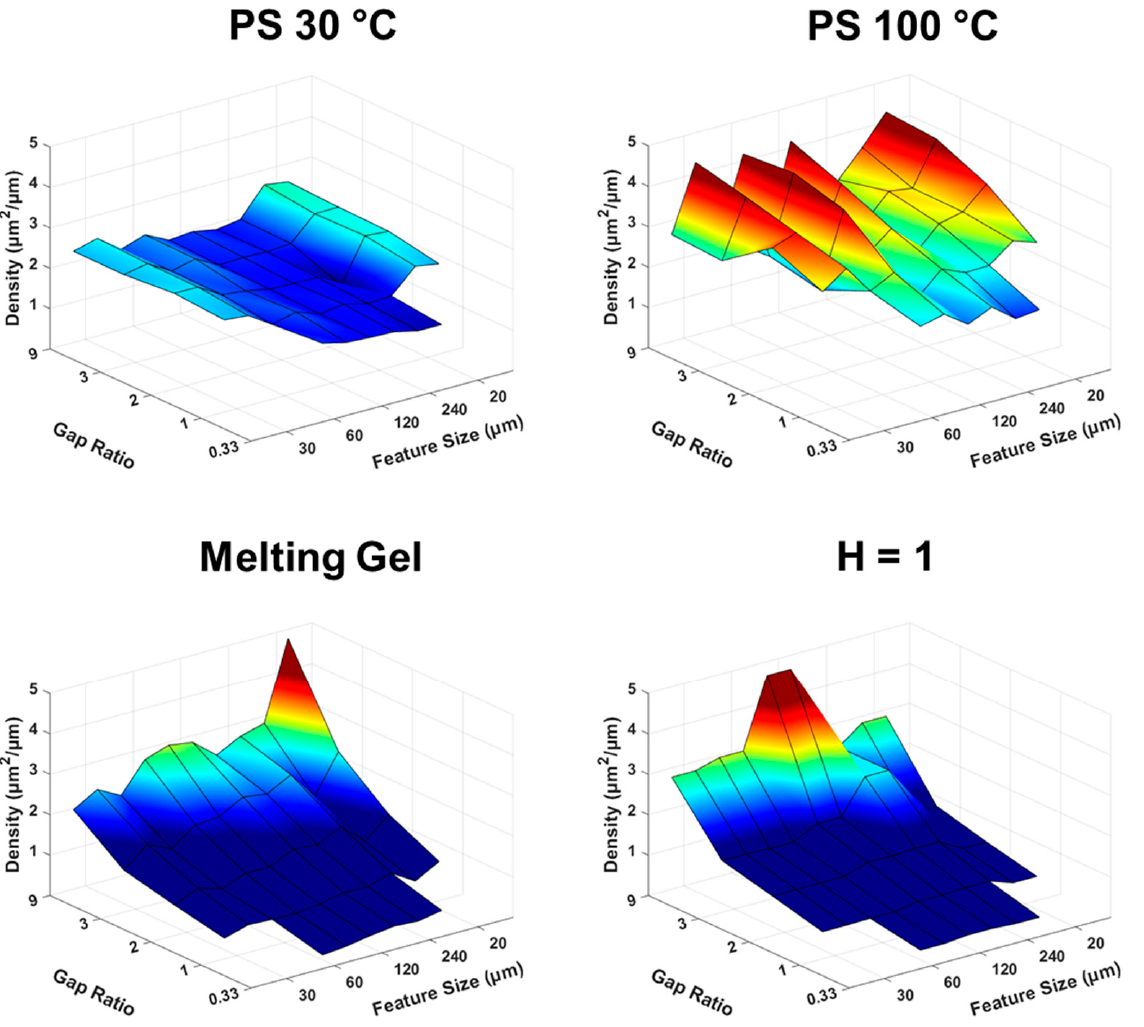
Figure 2. Surface maps of grating density plotted by their relative position on the chip. Note that 20 and 30 µ m features are positioned on opposite ends. The simulated indiscriminate coating ( H = 1) has been scaled to fit on the same axis as the real materials, but the actual values are arbitrary.